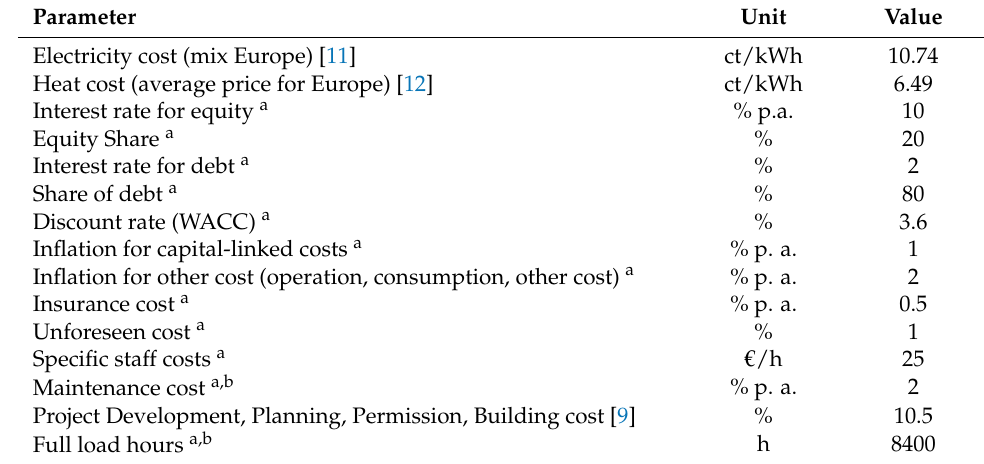
Table 1. Parameters and assumptions for economic